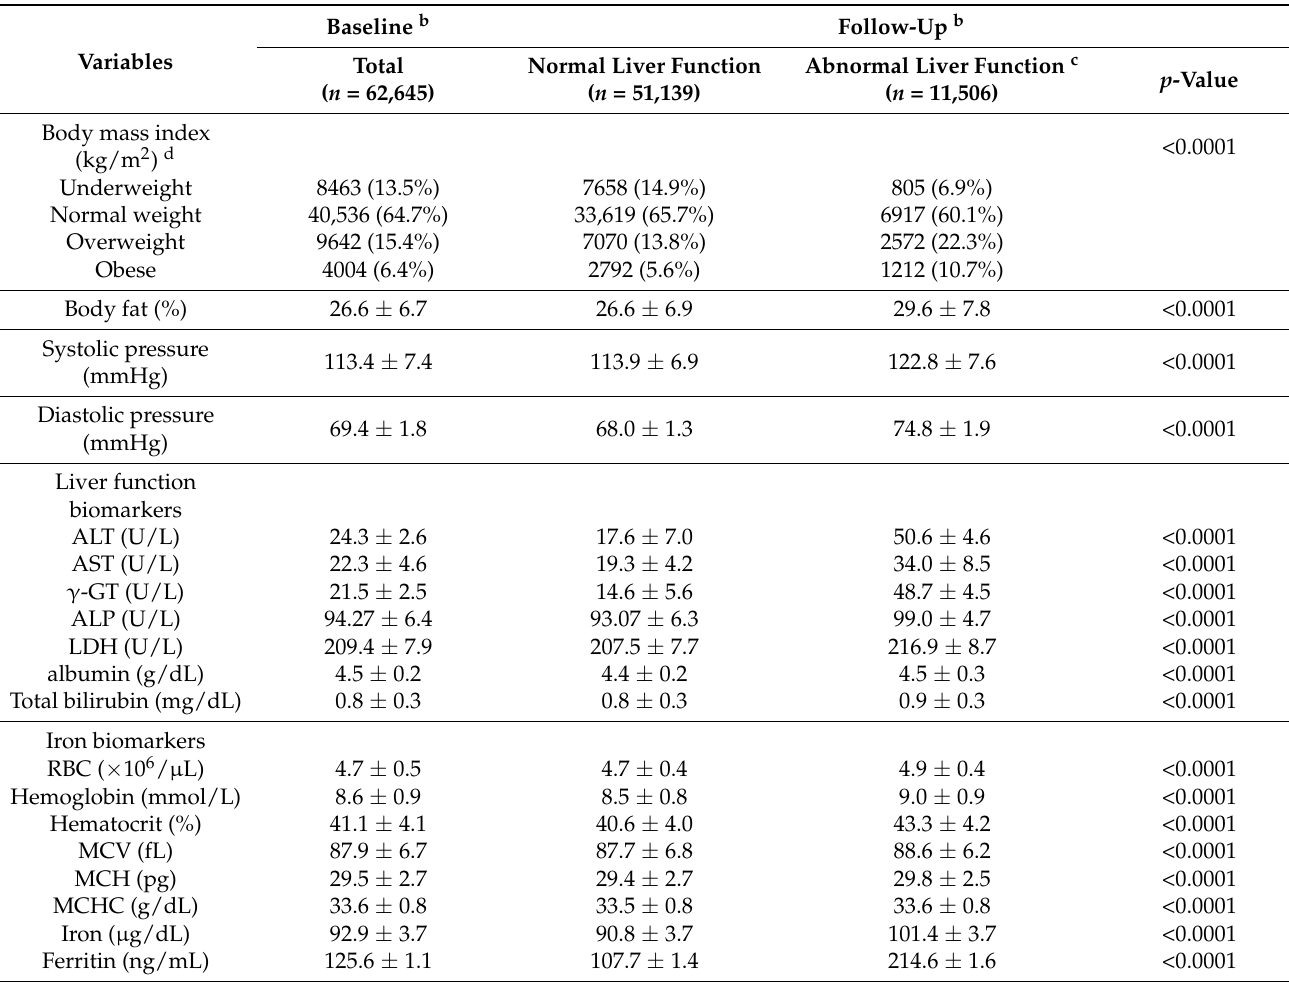
Table 2. Clinical and biochemical data of study participants classified by liver function ( n = 62,645) a .